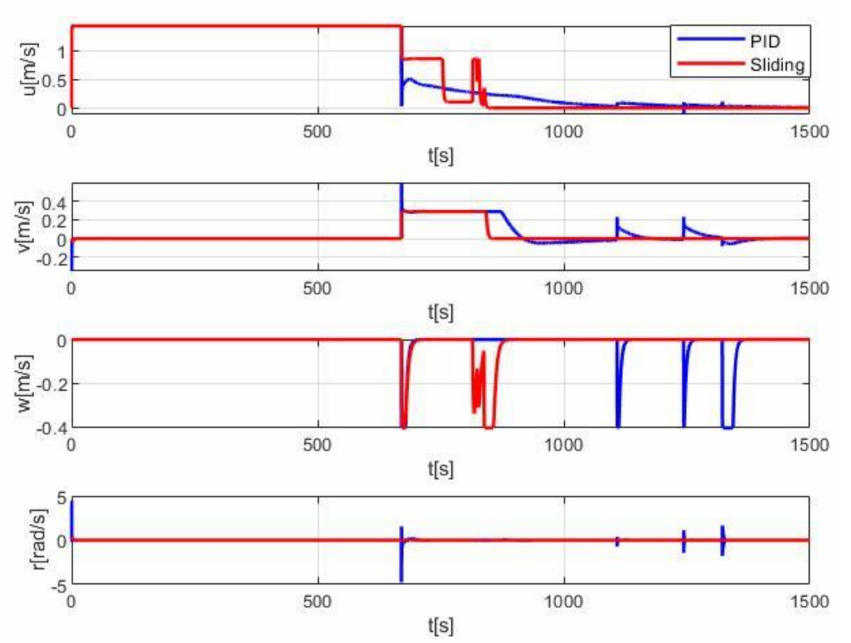
Figure 12. Time history of the velocity of the AUV.